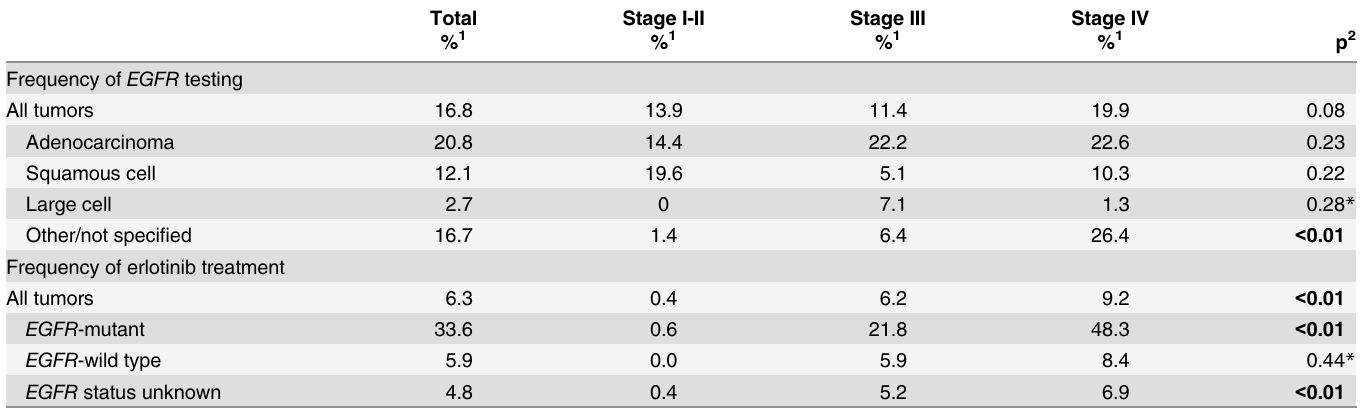
Table 2. Frequency of EGFR testing and receipt of erlotinib among non-small cell lung cancer patients diagnosed in 2010 overall and by tumor stage, Patterns of